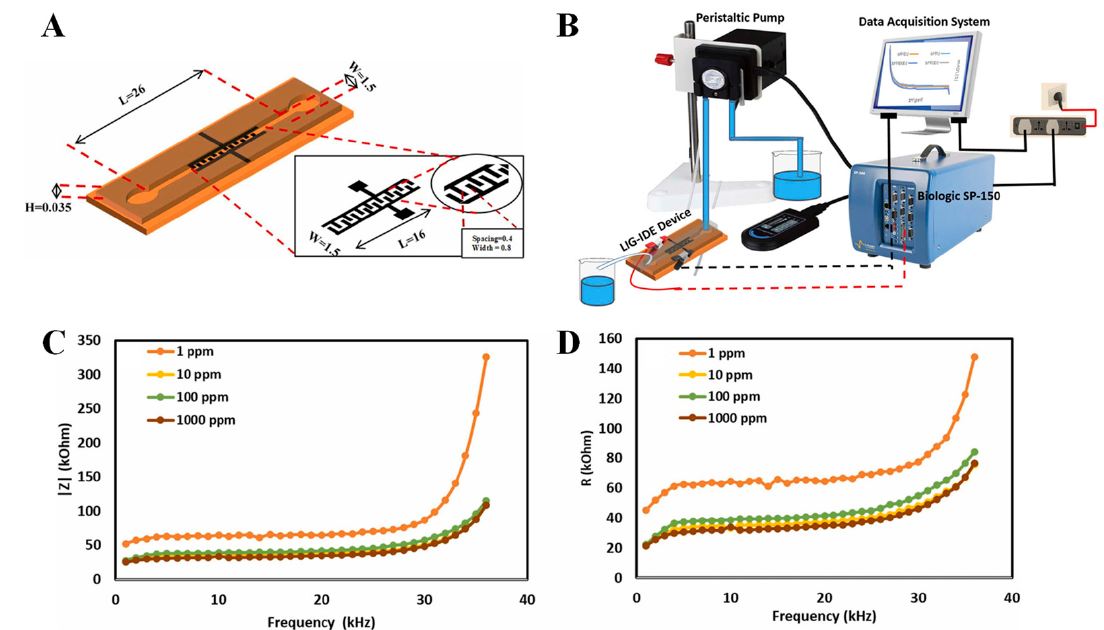
Figure 9. Schematic diagrams and sensing performance evaluation of laser-induced graphene-based microfluidic taste sensor. ( A ) Schematic image of microchannel and interdigitated electrodes in sensor; ( B ) diagram of complete detection system; ( C ) impedance spectroscopy results of taste sensor to L-tryptophan (bi tt er substance) expressed in terms of reactance on the frequency range; ( D ) impedance spectroscopy results of taste sensor to L-tryptophan (bi tt er substance) expressed in terms of resistance for the frequency range. Reproduced from [138] with permission of Elsevier.